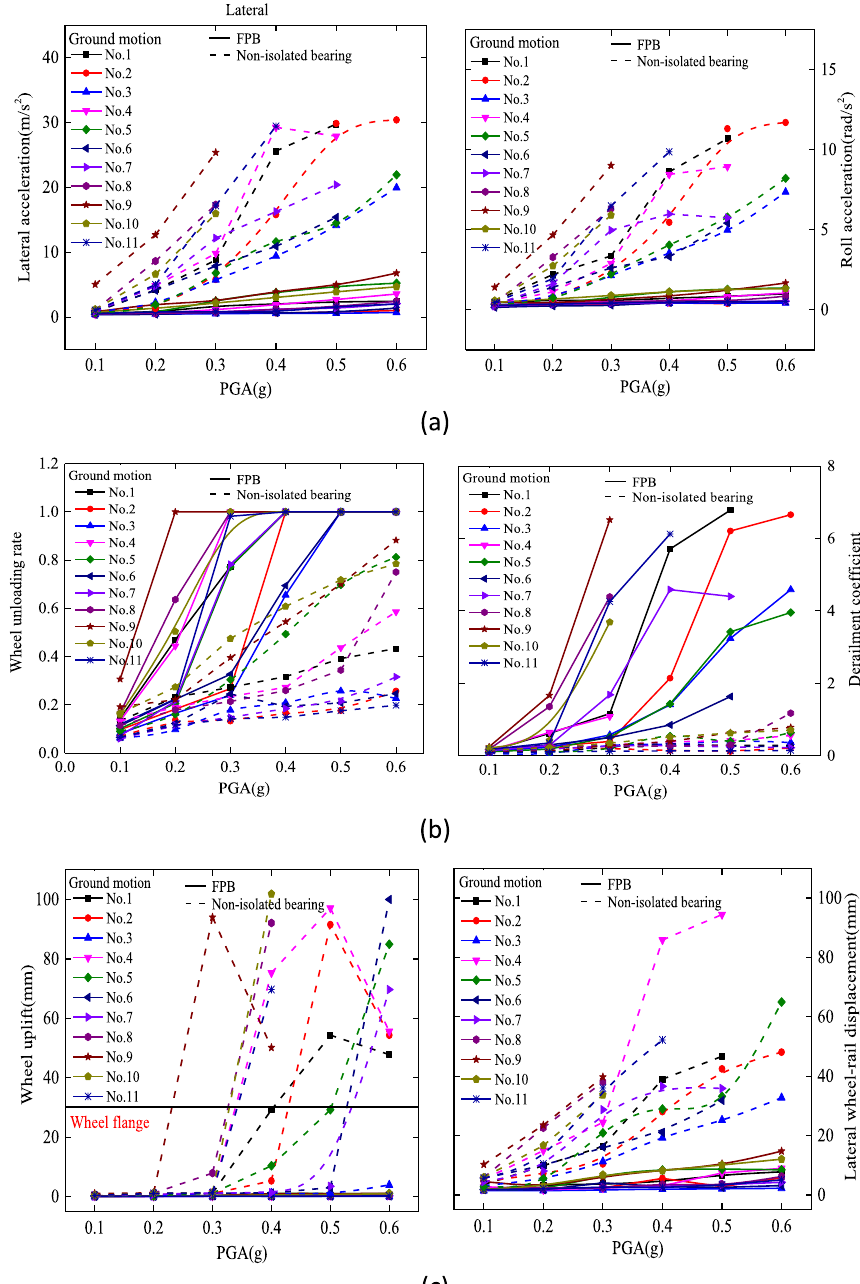
Fig. 24 IDA results of the dynamic response of the vehicle: a car-body’s acceleration; b assessment indices; and c wheel-rail relative